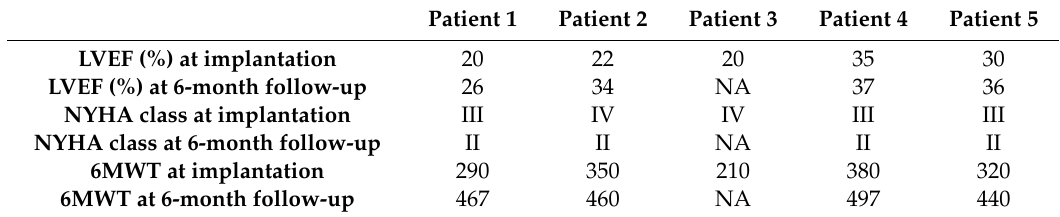
Table 3. LVEF, NYHA class, and 6MWT at baseline and last